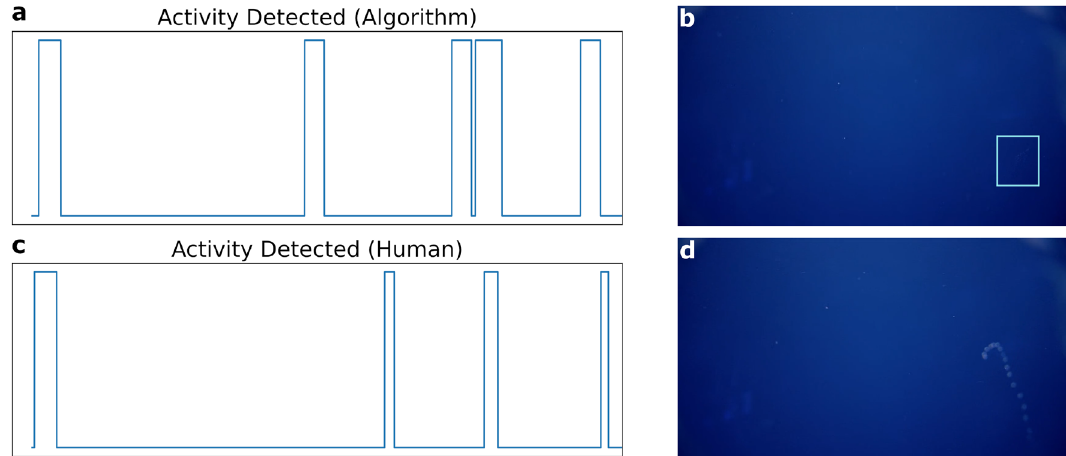
Figure 7. Comparison of activity recognition output from object detection ( a ) and a human expert ( c ) for one video collected by NOAA’s ROV Deep Discoverer during the CAPSTONE expedition 45 . In one instance ( b ), the algorithm (indicated by a bounding box) correctly identifies an animal with low contrast (image has been contrast enhanced). In another ( d ), the algorithm fails to identify an animal that is blurry due to unfocused